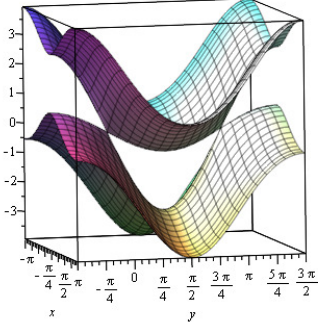
Figure 4. Dispersion of the quasiparticles (energy as a function of momenta k x = k 1 , k z = k 3 ) in the toy model of [31]. The vertical axis corresponds to energy, the two horizontal axes correspond to the two components of